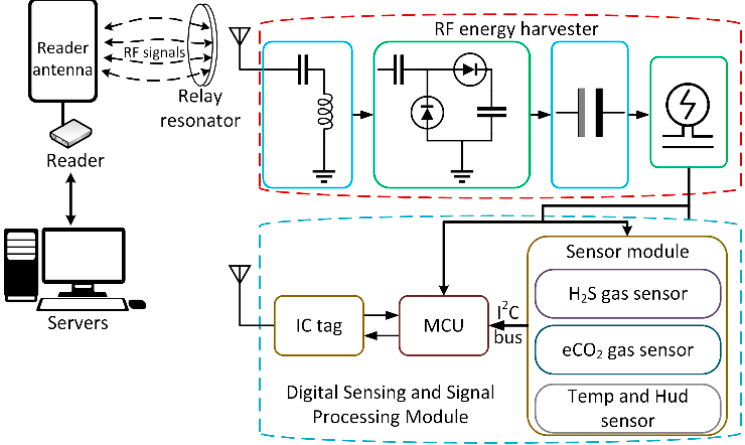
Figure 6. Block diagram of proposed passive smart sensor system.